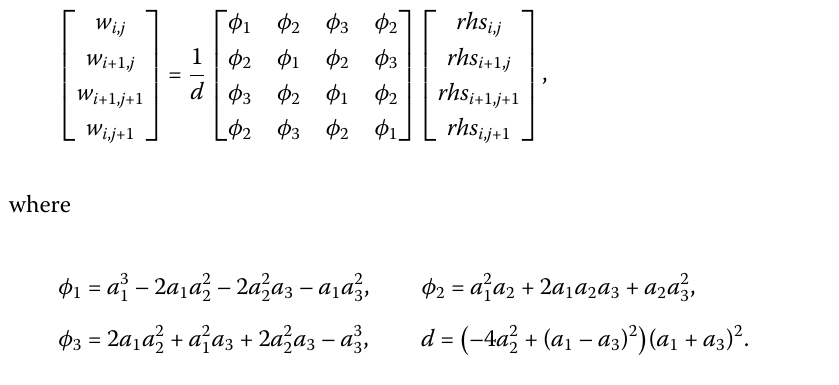
Figure 1 shows grid points on the x – y plane with mesh size m = 10, where the groups of four points are computed using (10) and the remaining points are computed using